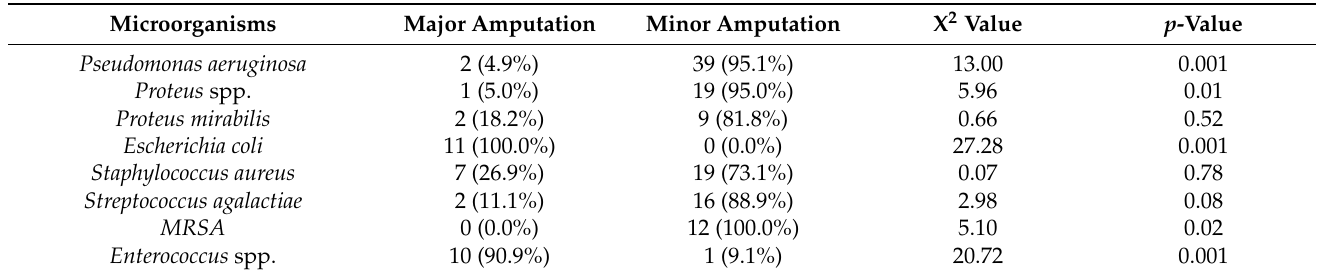
Table 10. Associations between amputations and the most common Gram-negative and Gram- positive